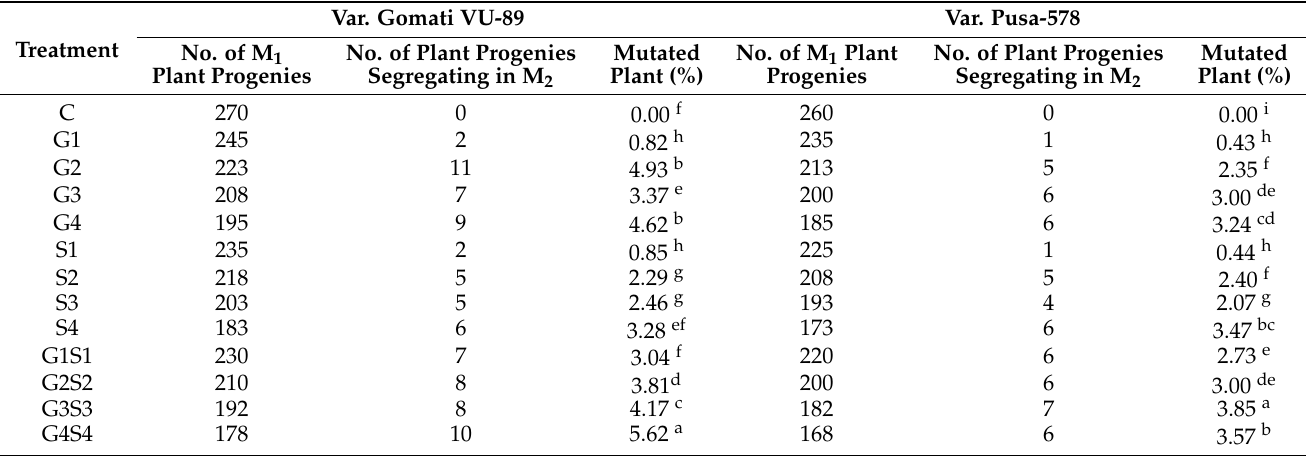
Table 1. The number of M 1 plant progenies, plant progenies segregating in M 2 , and percent of mutated plants.